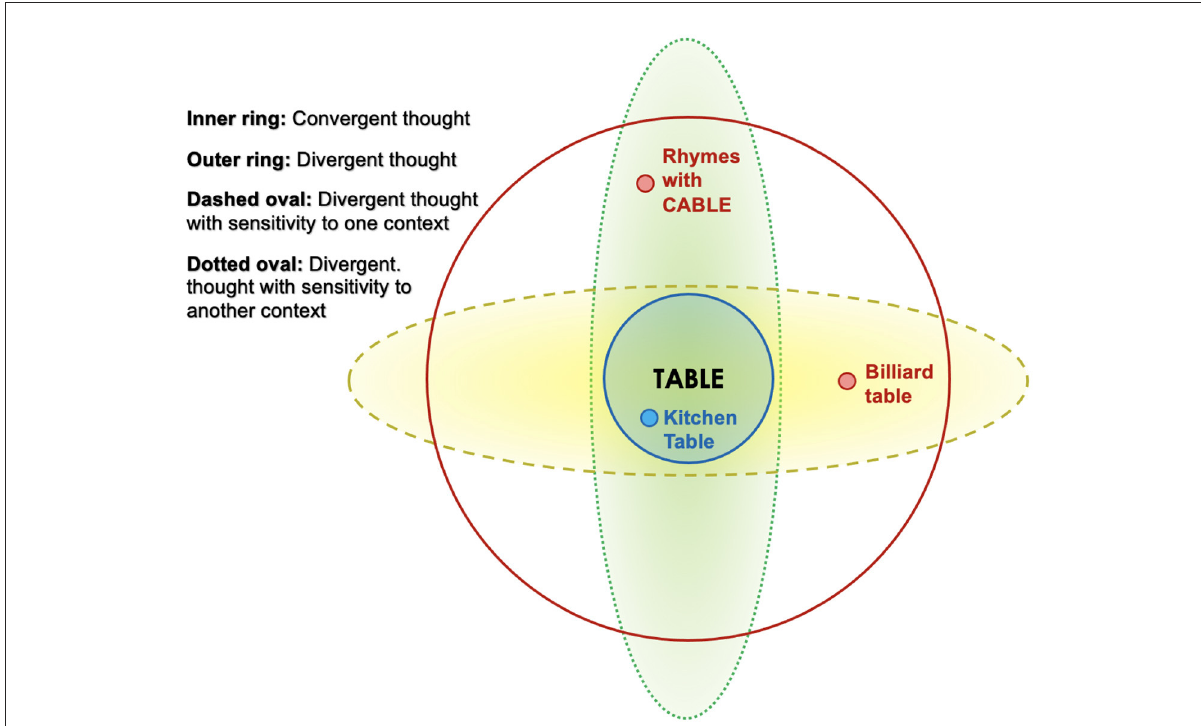
FIGURE1 Convergent thought (inner blue ring) is thought to be conducive to thinking of items that are directly related to the subject of thought. Thus, if one is thinking of the concept TABLE, divergent thought might lead to BILLIARD TABLE or to CABLE (since it rhymes with TABLE). Divergent thought (outer red ring) is conducive to thinking of “remote associates,” items that are somewhat related to the subject of thought (Mednick, 1962). Thus, if one is thinking of the concept, TABLE, divergent thought might lead to either BILLIARD TABLE or to CABLE (since it rhymes with TABLE). Context-sensitive divergent thought leads to remote associates that are relevant to the current goal. Thus, if the goal is to play a game, TABLE might lead to BILLIARD TABLE, but if the goal is to write rhyming poetry, TABLE might lead to